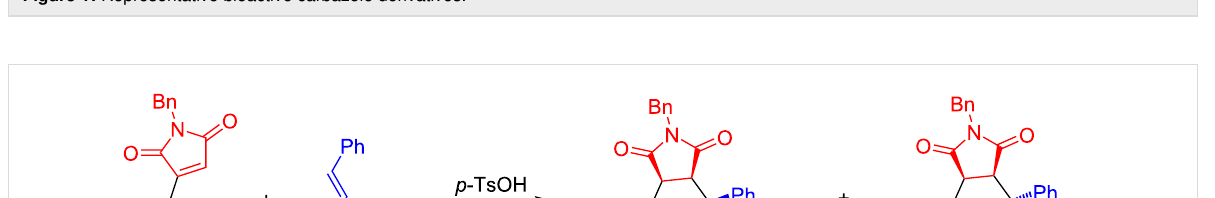
Figure 1: Representative bioactive carbazole derivatives.